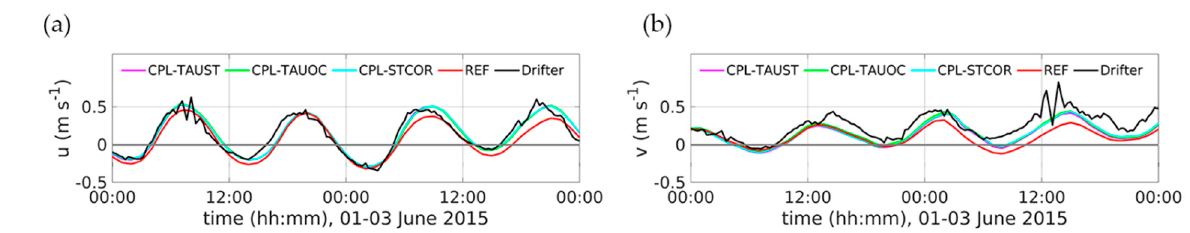
Figure 5. Velocity from drifter #5 and model runs. Zonal ( a ) and meridional component ( b ). Time period is 01–03 June 2015.